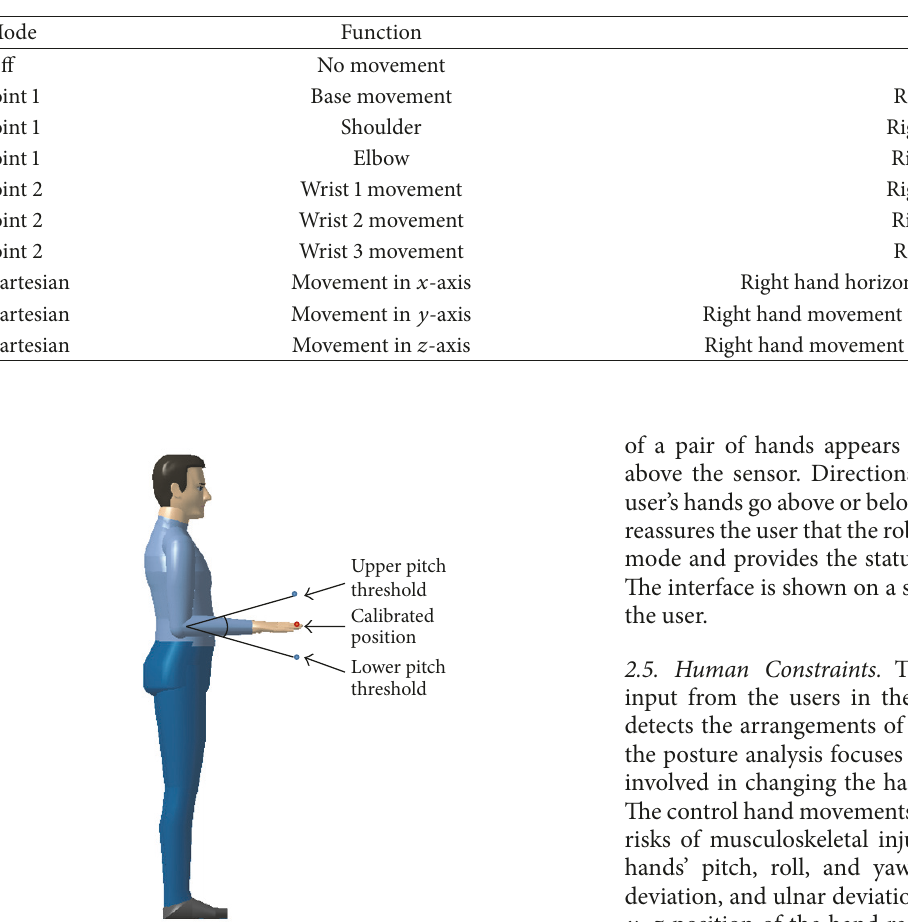
Table 1: User input and robot control mode.